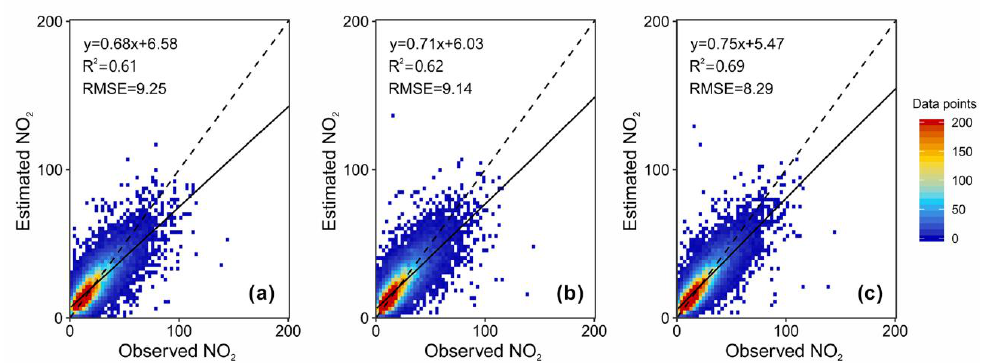
Figure 4. Site-based CV performance of the ( a ) GTWR, ( b ) global GRNN, and ( c ) GTW-GRNN models (N = 21,065). The dashed line refers to y = x reference, and the coordinate axis means NO 2 concentration with the unit of μ g/m 3 .